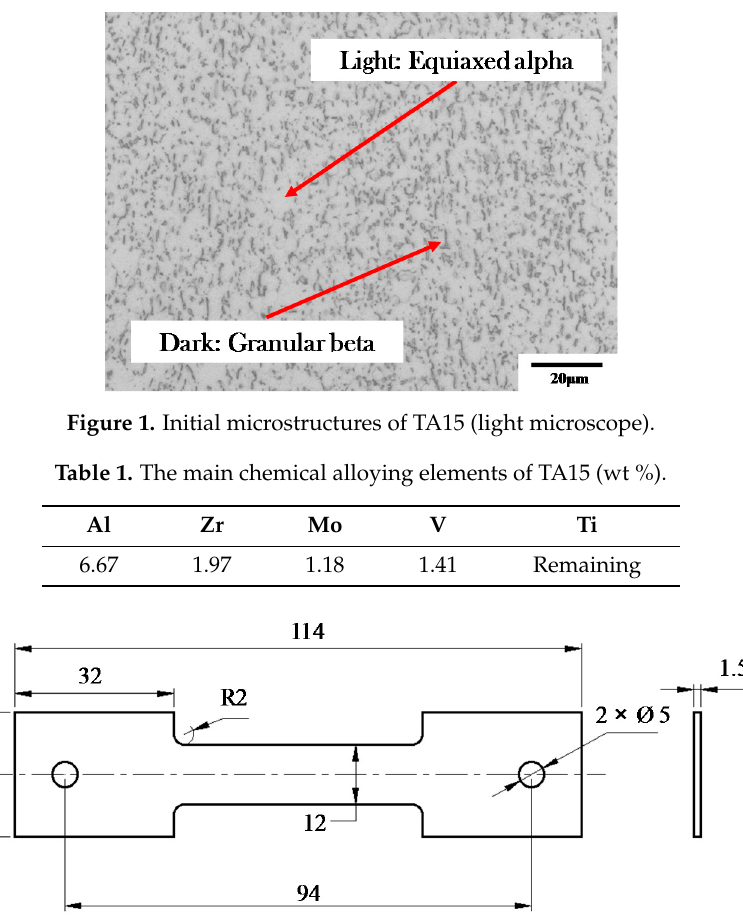
Figure 2. Hot tensile specimen design (all dimensions are in mm).